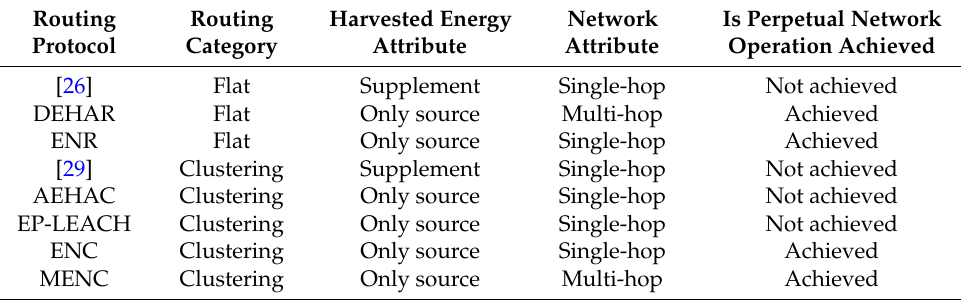
Table 1. Performance comparison among energy harvesting aware routing protocols.